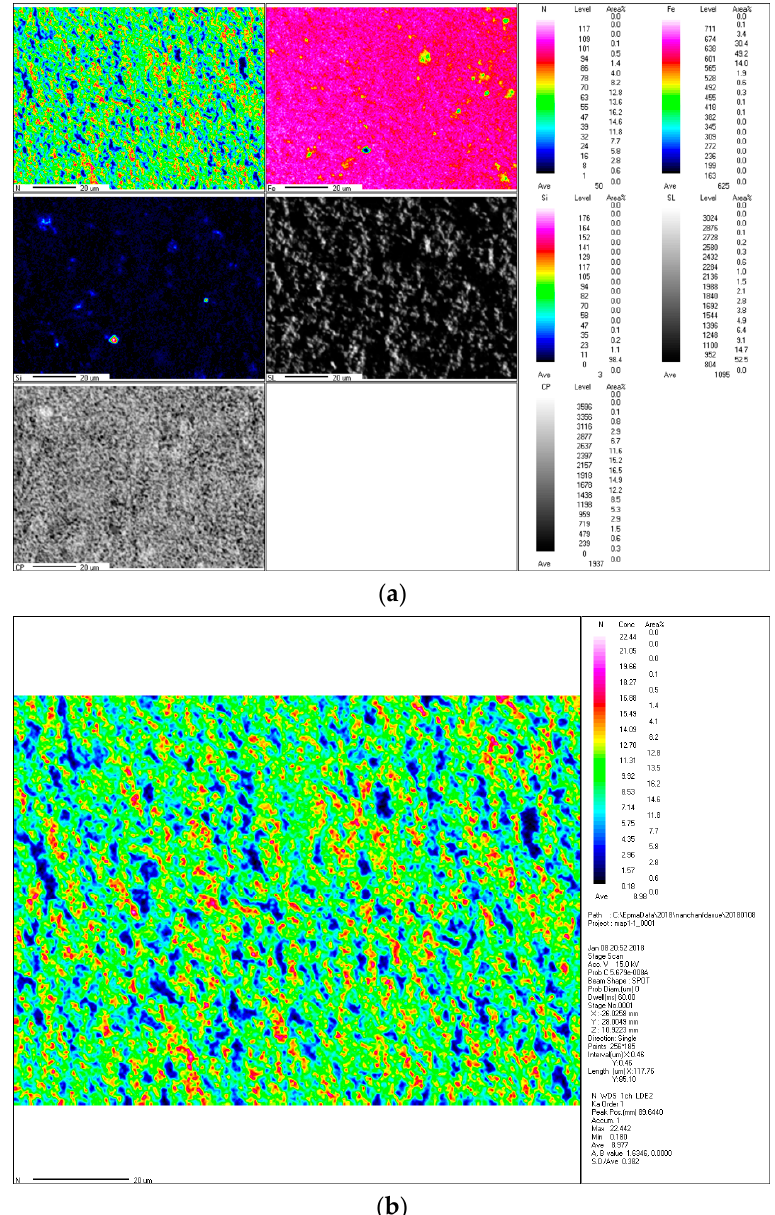
Figure 5. The ε -Fe(Si) 3 N powder element distribution ( a ) Fe, Si and N element distribution. ( b ) N element distribution.